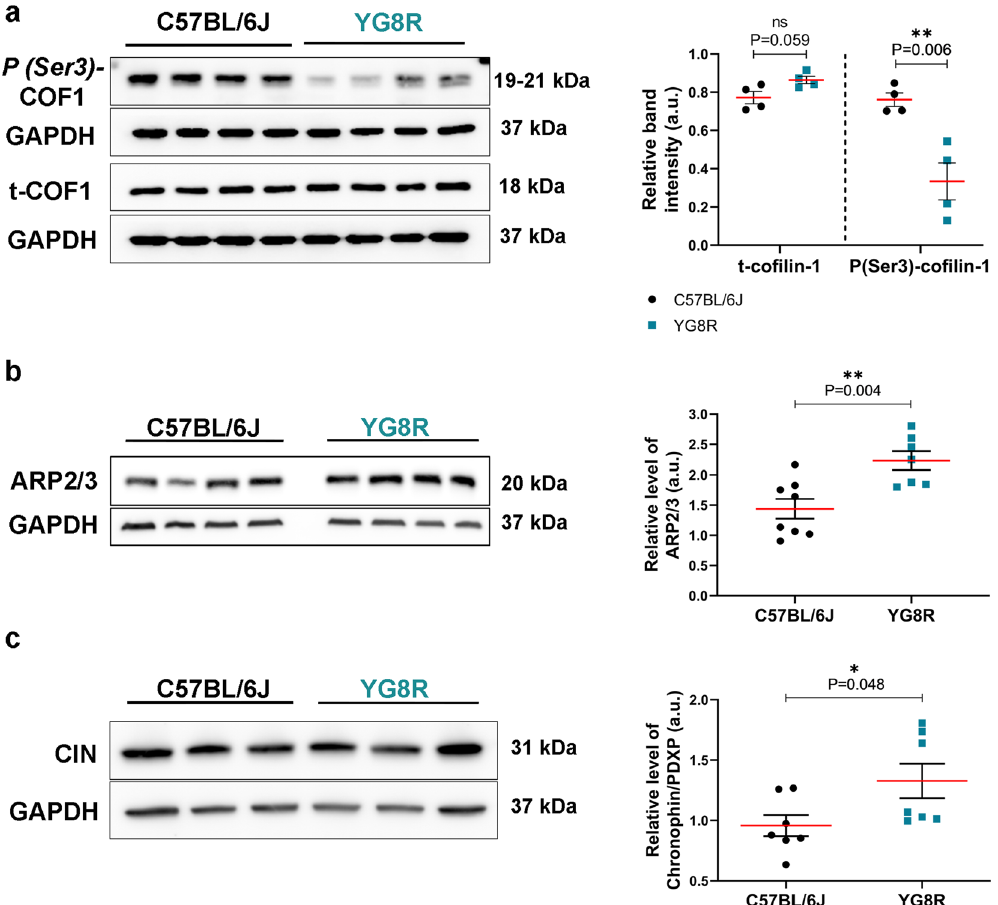
Figure 3. Frataxin deficiency in sensory neurons of YG8R mice modulates the activity of cofilin, ARP2/3 complex and the phosphatase Chronophin. Western blots and quantitative analysis of the expression of total cofilin (active form) and phosphor (Ser3)-cofilin (inactive form) ( a ), the ARP2/3 complex ( b ) and the phosphatase Chronophin (CIN) ( c ) in dorsal nerve roots of YG8R and control mice (C57BL/6J). Total cofilin exhibited an increase in dorsal nerve roots of YG8R mice compared with control mice (C57BL/6J), whereas the P(Ser3)-cofilin expression was reduced significantly, suggesting an increase in cofilin activity (n = 4 per genotype). In addition, there was a significant increase in the expression of ARP2/3 complex in dorsal nerve roots of YG8R mice (n = 8) compared to controls (C57BL/6J, n = 7). The expression of the phosphatase CIN also resulted in a significant increase in dorsal nerve roots of YG8R mice (YG8R, n = 8; Control, n = 8). The red horizontal bar indicates the mean. All the values are plotted with ± s.e.m. Quantitative Significant changes between genotypes were assessed using Student’s t-test. * P ≤ 0.05, ** P ≤ 0.01. Full-length blots are presented in Supplementary Fig.